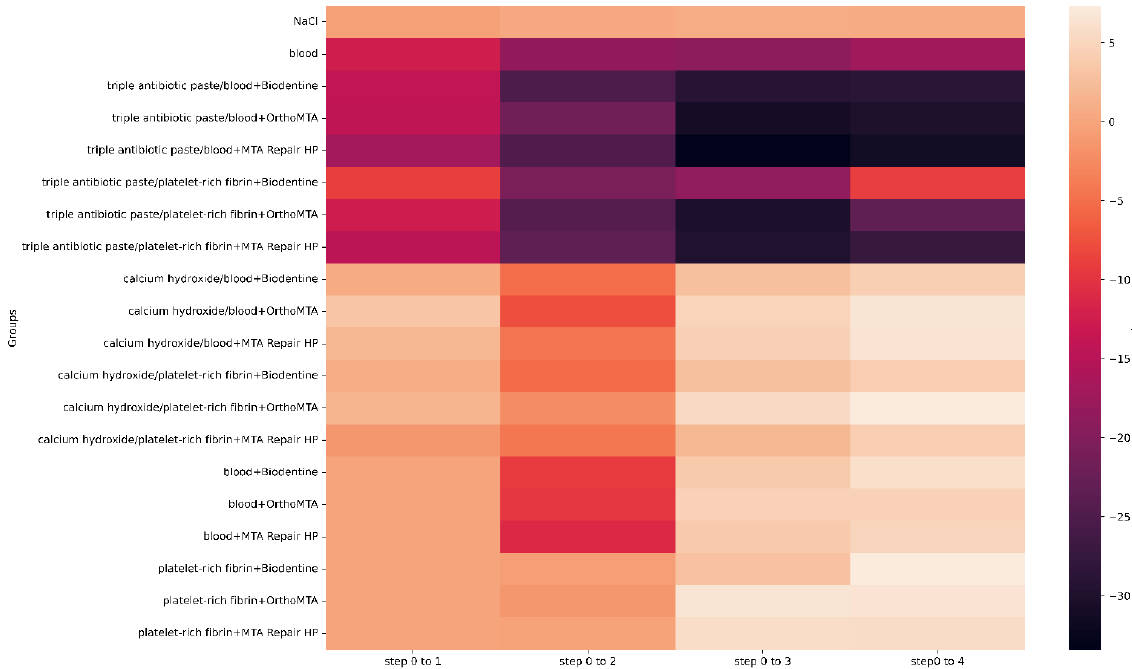
Figure 5. Values of ∆L for all groups and steps.